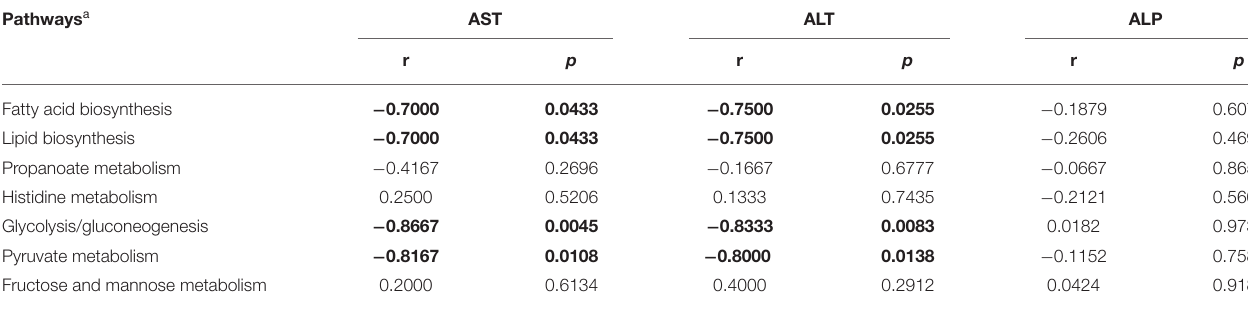
TABLE 2 | Spearman’s correlation of pathways and indices of liver function. Pathways